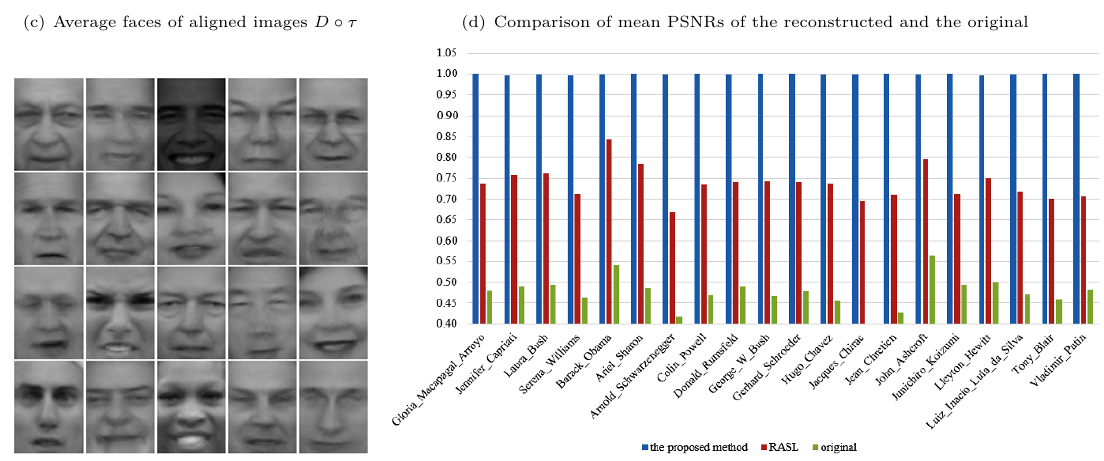
Fig. 4 Experimental results using real face images. (a) Averages of original unaligned face images of 20 persons from LFW. (b) Mean PSNR of original images and images aligned by two methods, for each person. (c) Average faces using aligned images for each person. (d) Mean PSNR of original images and images reconstructed by two methods, for each person. (e) Average faces using reconstructed images for each person. (f) Mean SSIM of original images and images aligned by two methods, for each